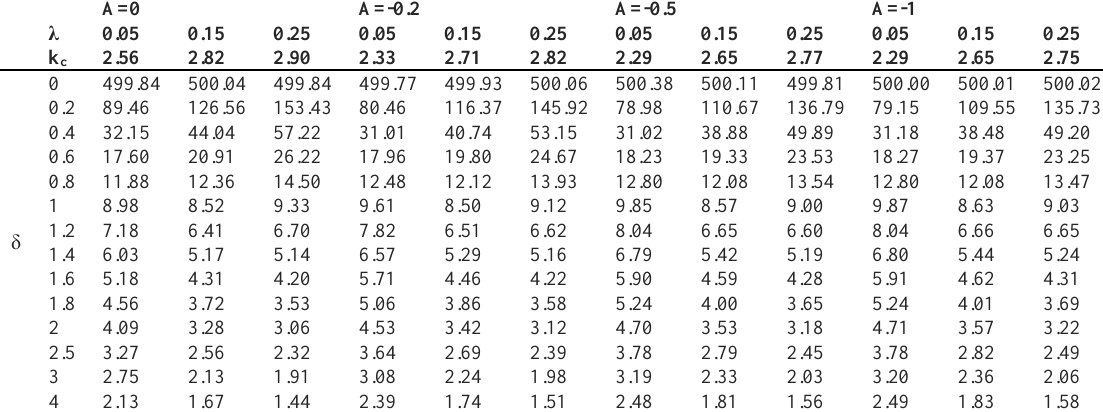
Table 3. ARL results for steady-state constant limit one-sided